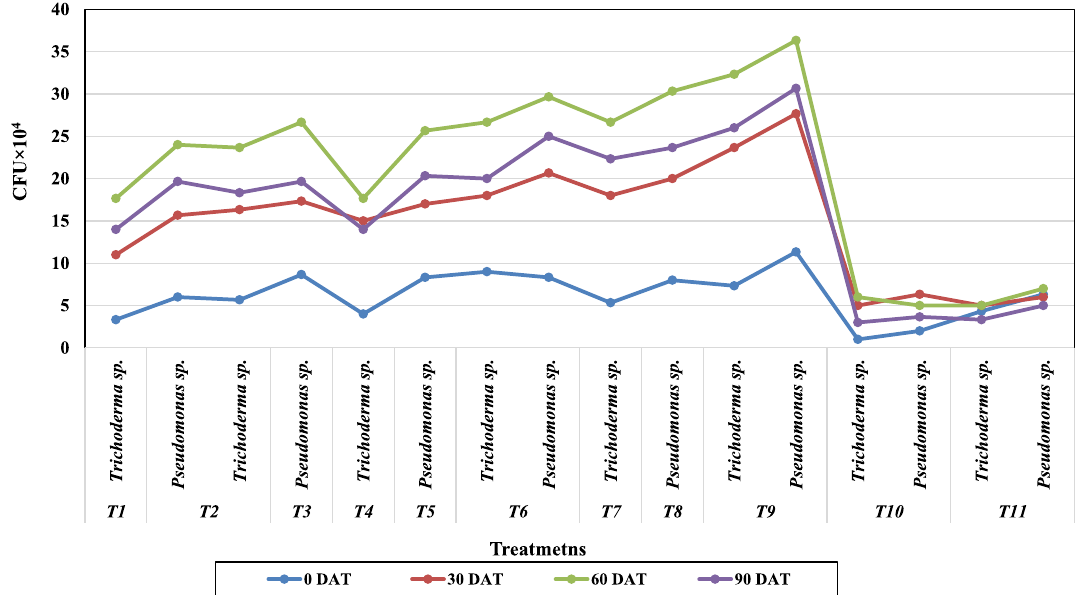
Fig. 3 Rhizosphere Population of Trichoderma spp. and Pseudomonas fluorescens in different combinations of